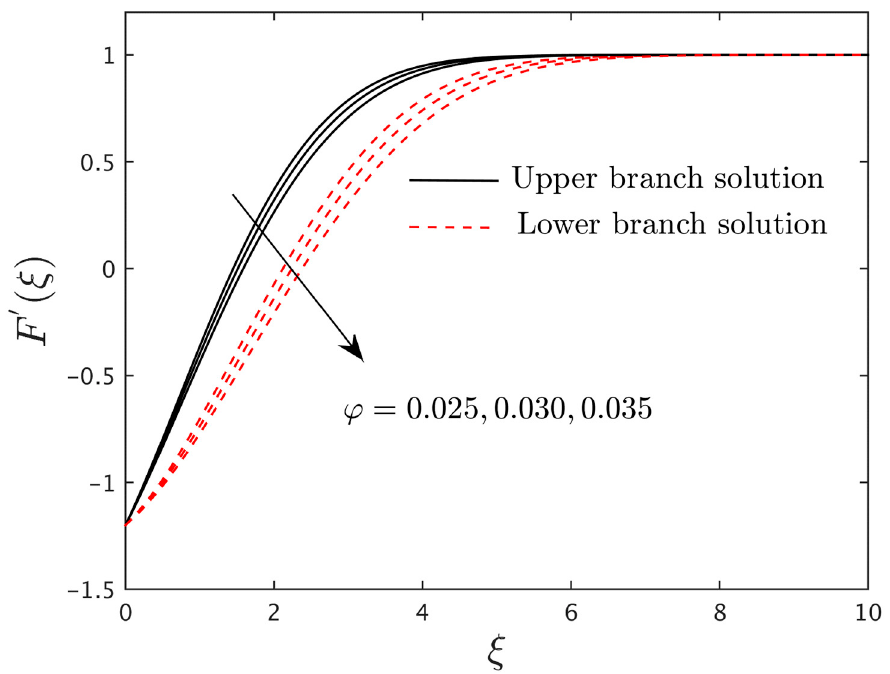
Figure 6. The velocity profiles F (cid:48) ( ξ ) for the several values of ϕ when Pr a = 1.0, Sc a = 10.0, Pr = 6.2, Σ a = 0.05, and γ s = 0.5.